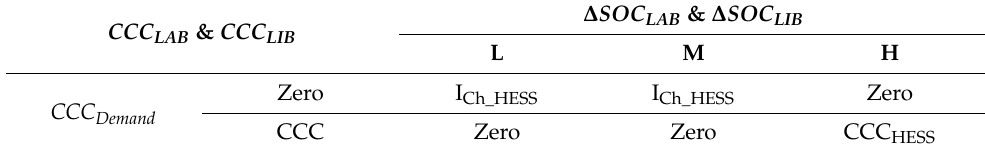
Table 5. FLC rules.